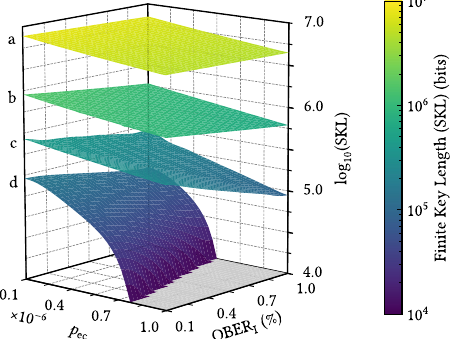
Fig. 4 SKL versus p ec and QBER I . Single zenith overpass with η sys values: a 27 dB, b 33 dB, c 37 dB, and d 40 dB. The grey region indicates zero